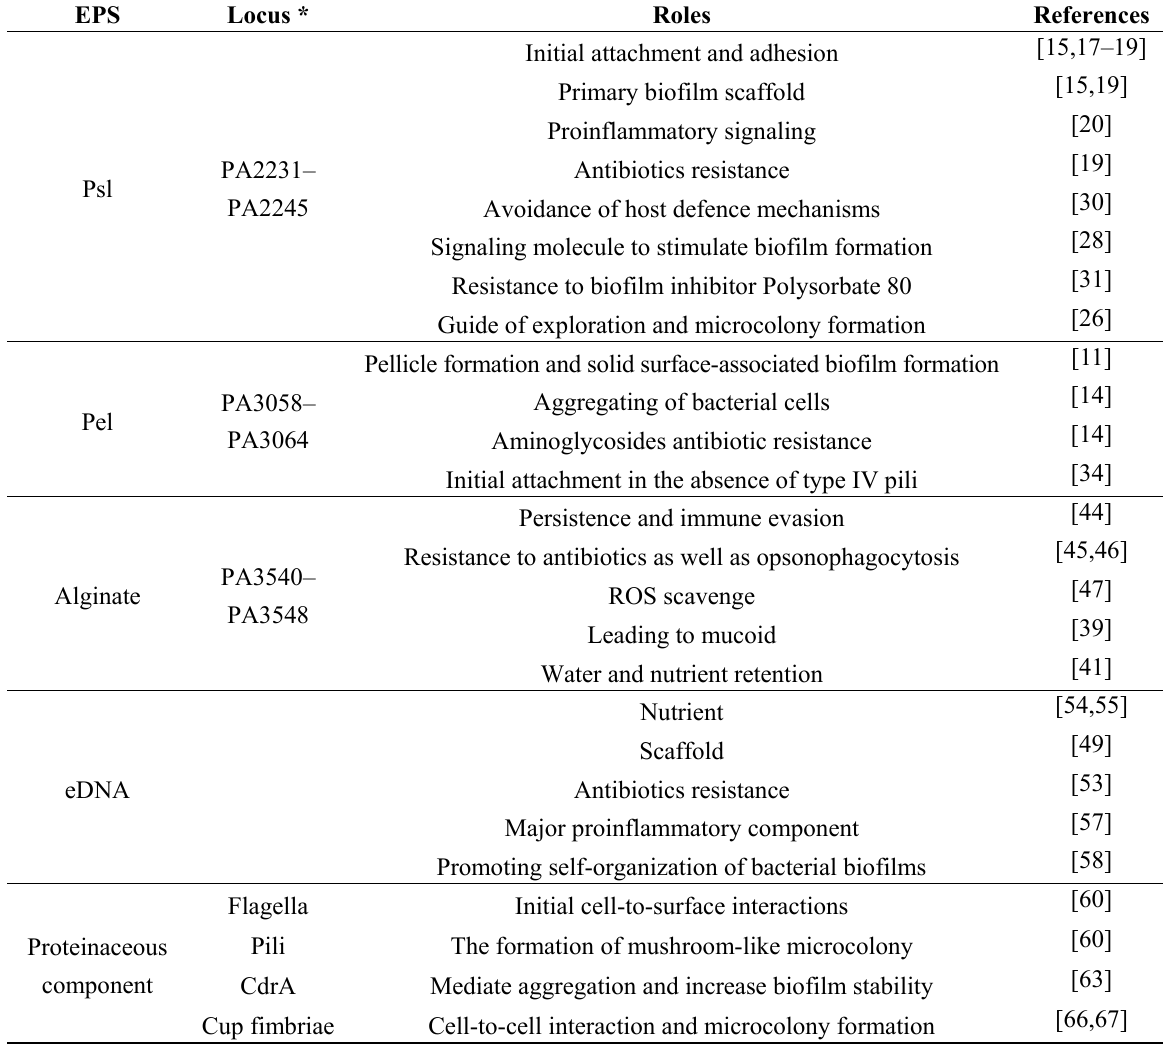
Table 1. Roles of different exopolysaccharides (EPS) in Pseudomonas